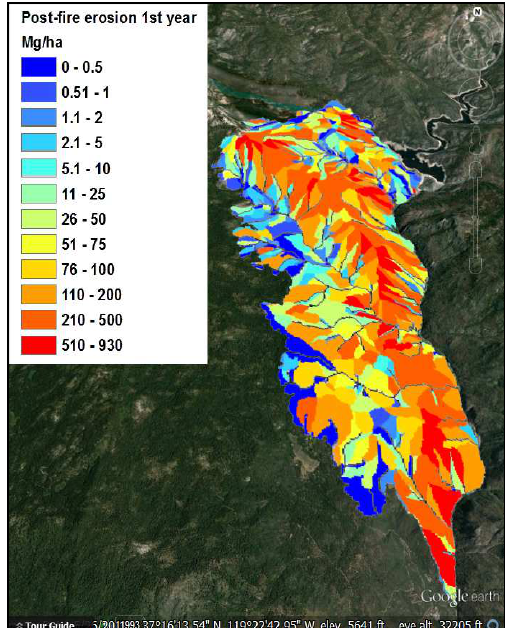
Figure 5. Post-fire hillslope erosion predictions for the French fire displayed in Google Earth.